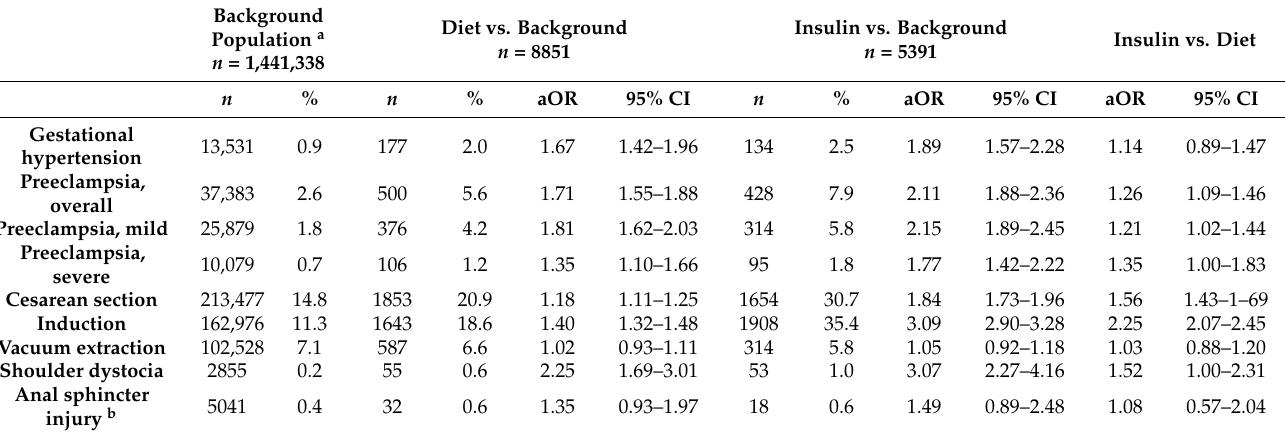
Table 2. Maternal pregnancy outcomes in singleton pregnancies diagnosed with diet- or insulin- treated